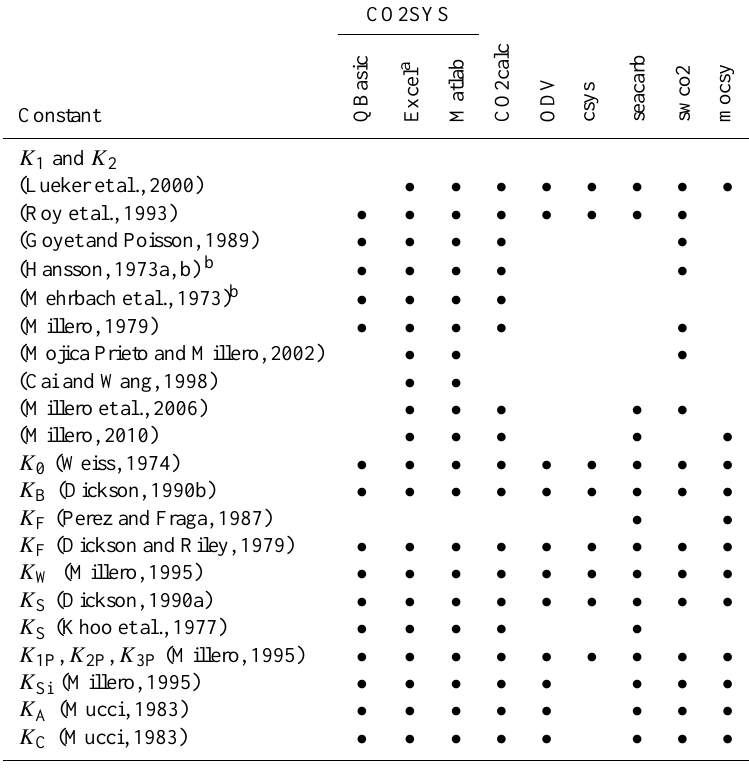
Table 6. Available constants for each